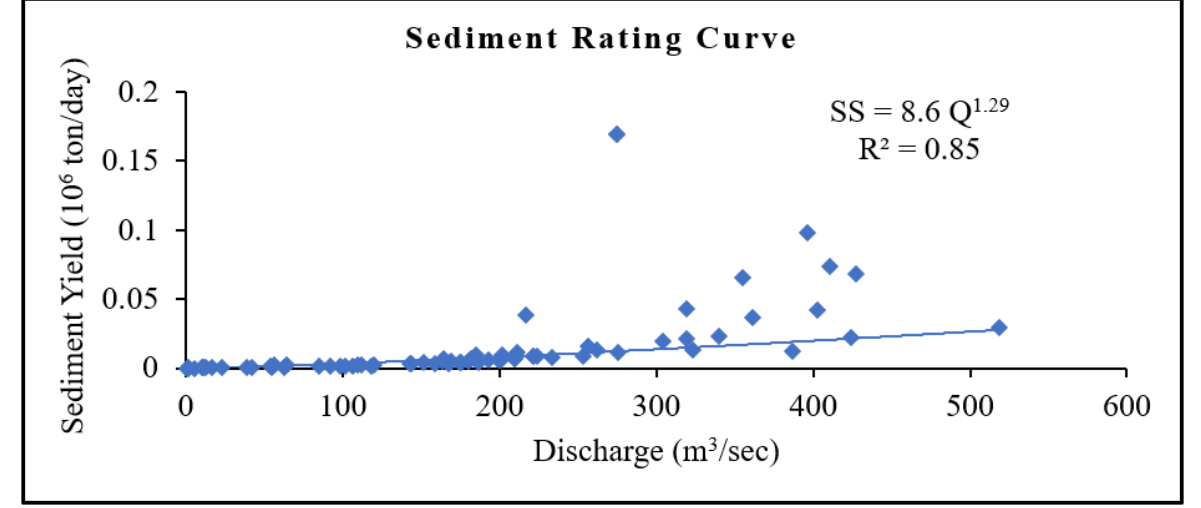
Figure 4. The best fit sediment rating curve for Genale Dawa-3 dam watershed.